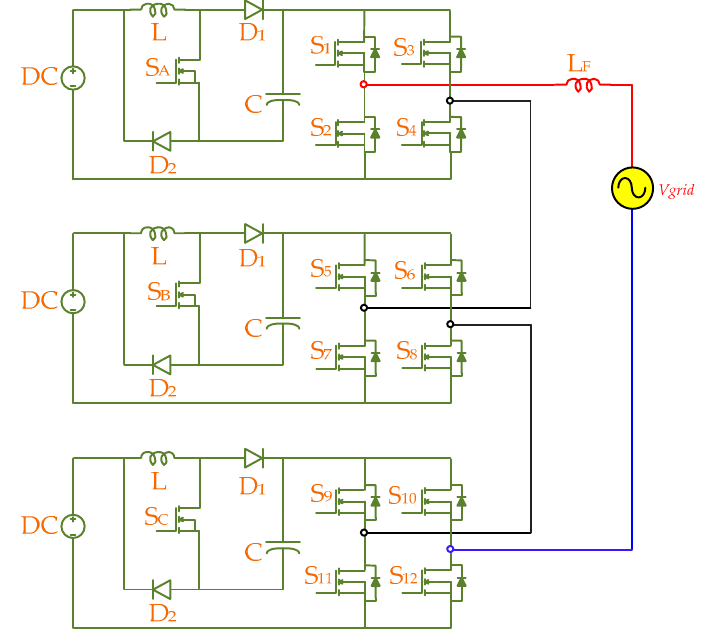
Figure 28. DC-Link qSBI cascaded multilevel inverter topology.